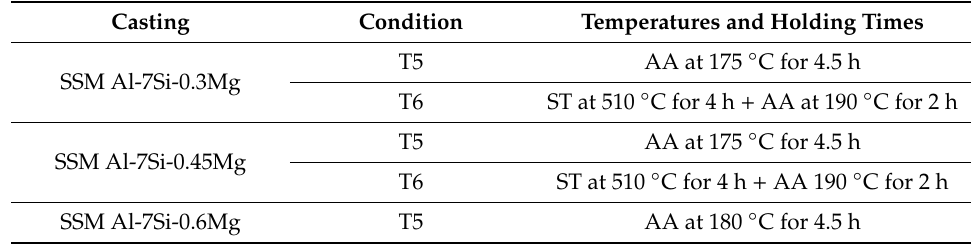
Table 2. Temperatures and isothermal holding times used for Solution Treatment (ST) and Artificial Aging (AA) of the di ff erent SSM Al-7Si-Mg